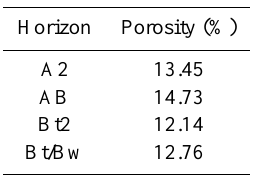
Table 2. Porosity percentages using thresholding criteria (Pi˜nuela, 2009).